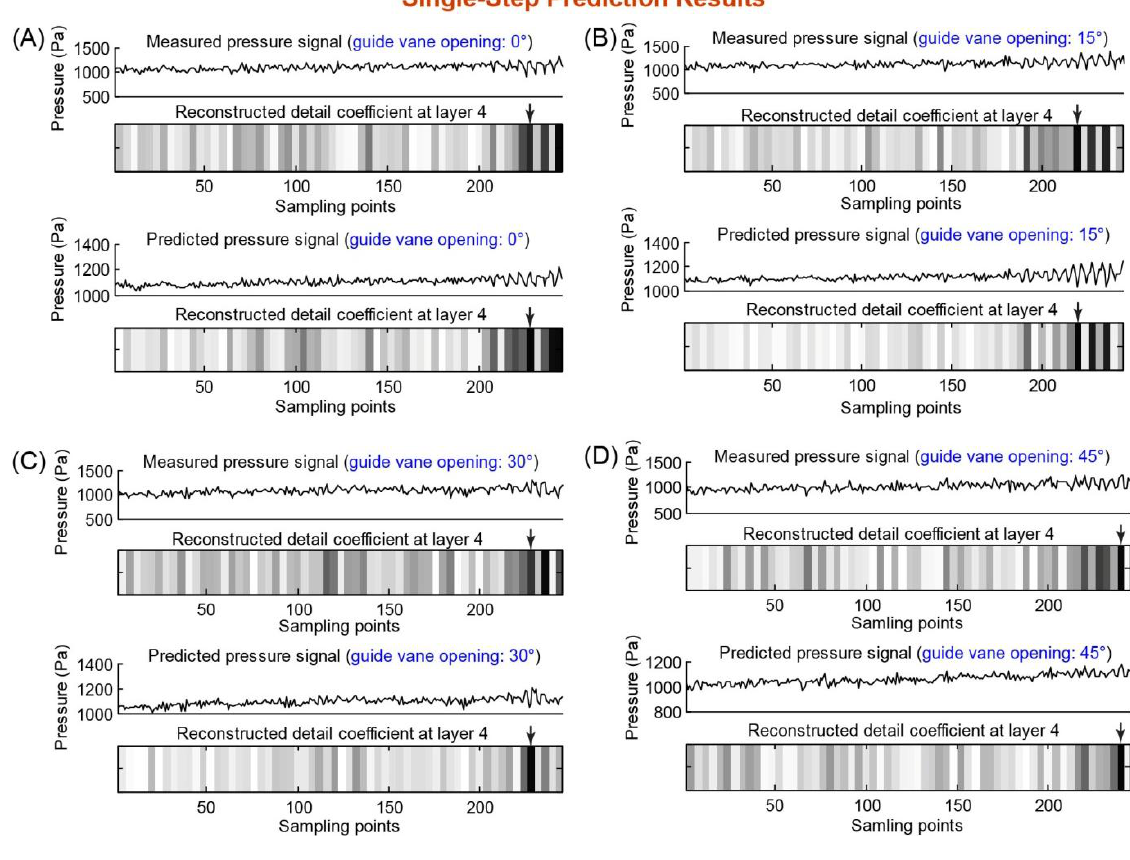
Figure 4. Single-step prediction results of the fan rotating stall at guide vane openings of 0°, 15°, 30° and 45° (panels ( A )–( D )). In each panel (( A )–( D )), the experimental measured pressure signal and its wavelet analysis result ( i.e ., fourth-layer detail coefficient) are shown on the top, and the SVRM-predicted pressure signal and its wavelet analysis result ( i.e ., fourth-layer detail coefficient) are shown on the bottom. The arrows on the fourth-layer detail coefficient plot indicate the starting points of the rotation